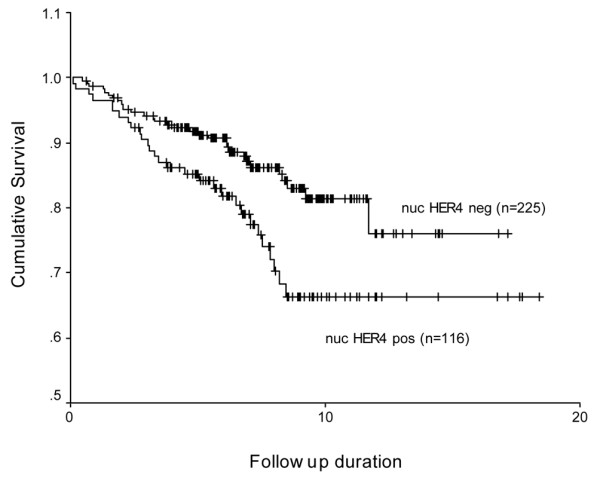
Cumulative survival differences between patients positive or negative for nuclear HER4 using the H4.77.16 antibody. Kaplan-Meier survival curves demonstrating cumulative survival differences (endpoint breast cancer related death) between patients positive or negative for nuclear (nuc) HER4 using the H4.77.16 antibody. P values represent log rank testing of the difference in cumulative disease free survival.